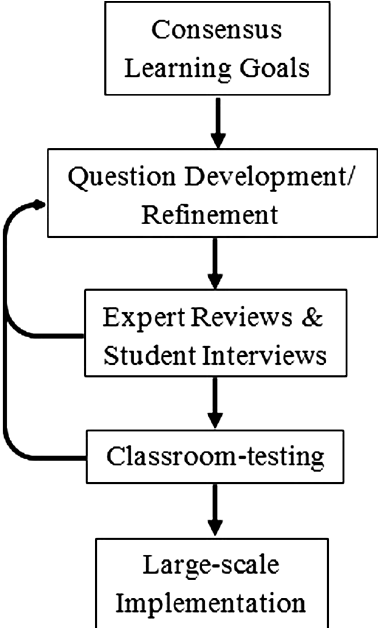
FIG. 1. A schematic of the design process used to develop CU ’ s upper-division conceptual